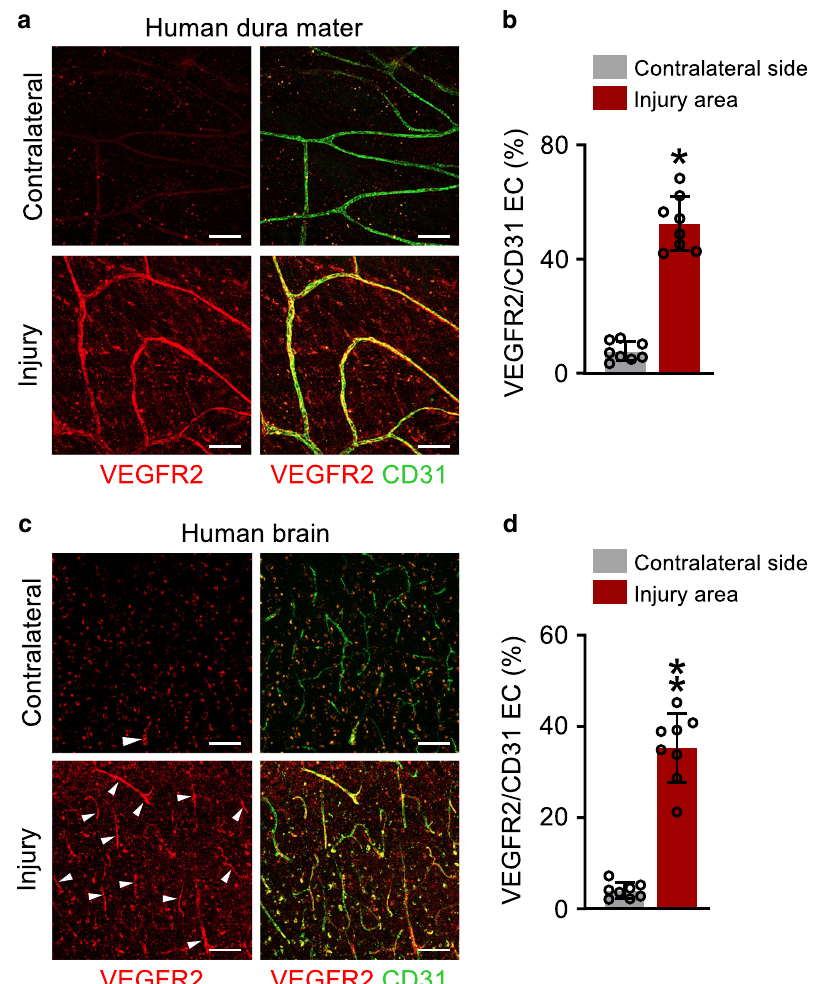
Fig. 4 VEGFR2 upregulation in blood vessels of injured dura mater and brain in human patients with traumatic head injury. a – d Representative images and comparisons of VEGFR2 upregulation in the BVs of injury area and contralateral (CL) side of human dura mater and brain at 24 h post-mortem from patients with HI. White arrowheads indicate VEGFR2 + BVs. Scale bars, 100 µ m. Two values were obtained from two areas of each patient sample, n = 4 patients from four independent experiments. Vertical bars indicate mean ± SD. ** P = 0.0002 versus CL by two-tailed Mann – Whitney U